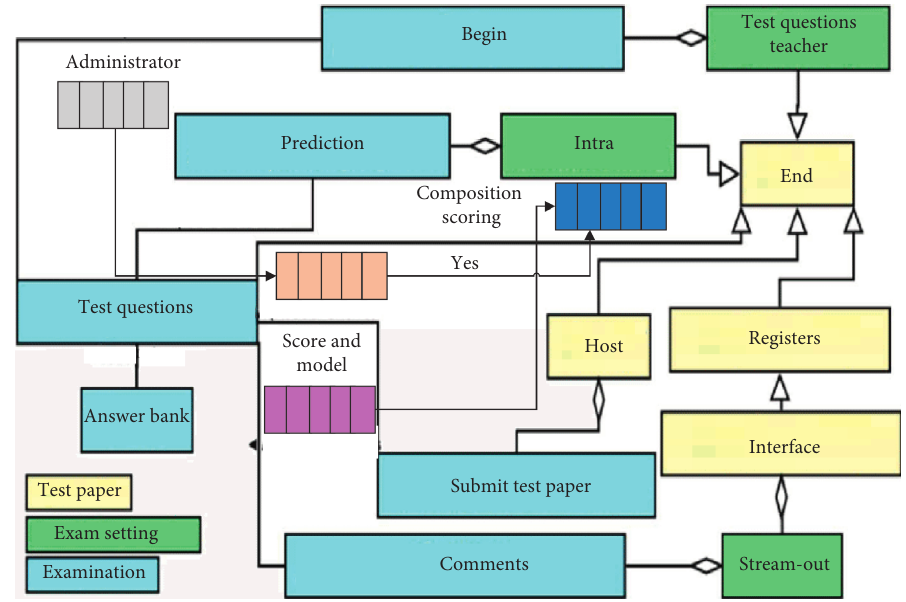
Figure 2: Flow chart of the examination and marking system.